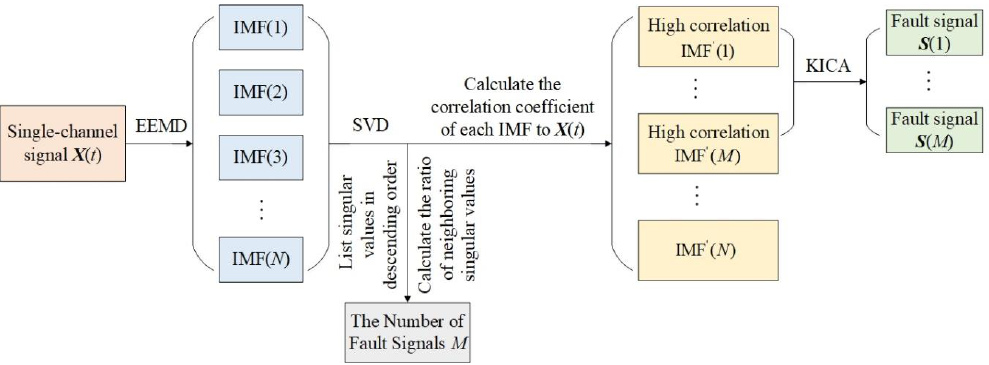
Figure 1. The summarized procedure of the proposed method.